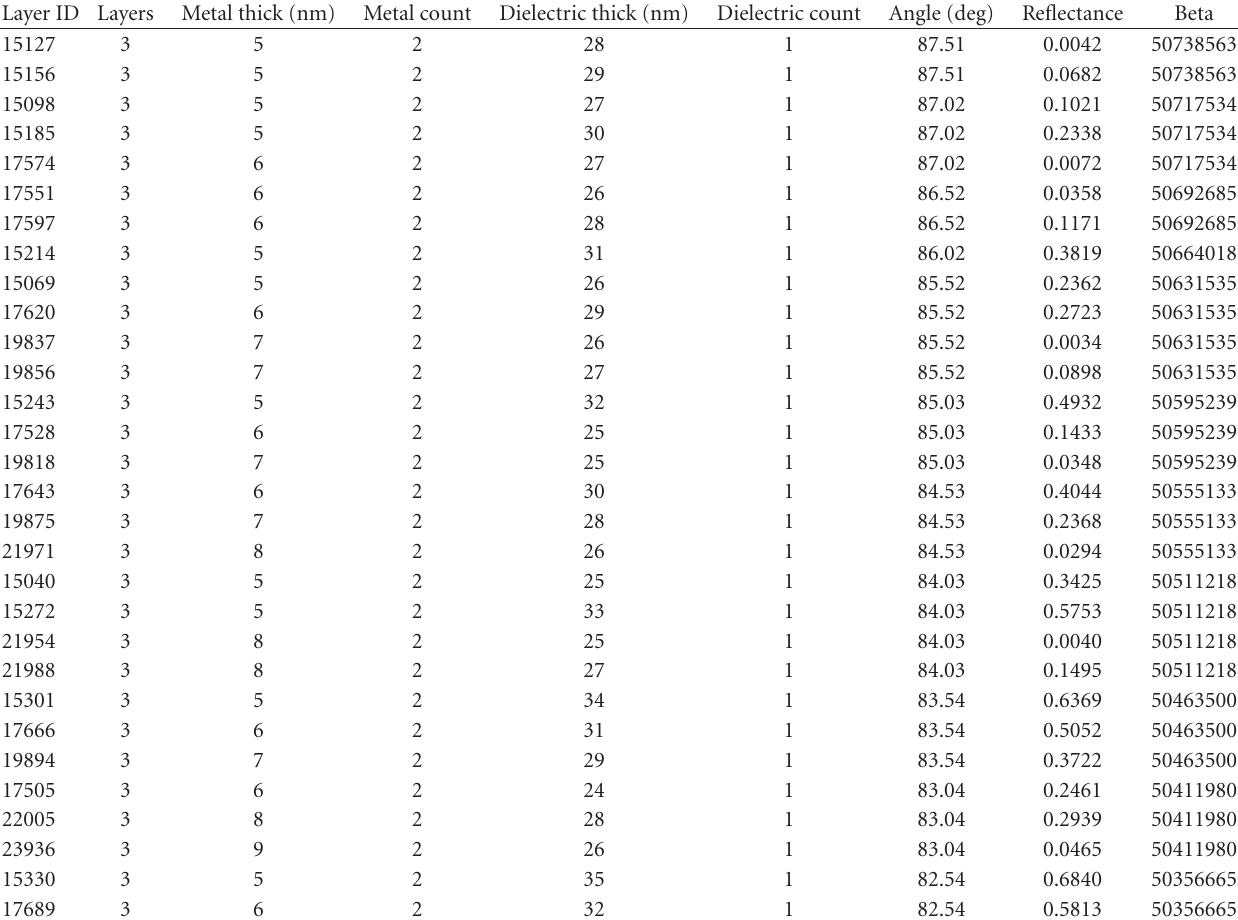
Table 1: Joined data in